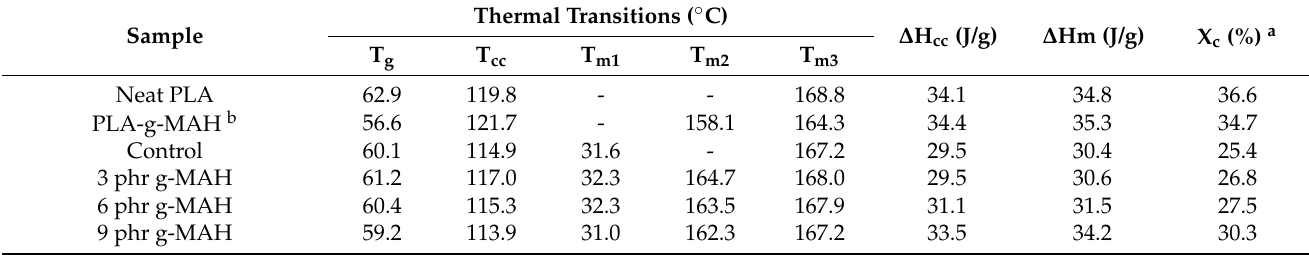
Figure 5. DSC thermogram of neat PLA, PLA-g-MAH, and PLA/PBSeT blend films without PLA-g- MAH (control) and with various PLA-g-MAH contents. Table 2. Thermal characteristics from the DSC analysis of PLA/PBSeT blends without PLA-g-MAH (control) and with various PLA-g-MAH contents.